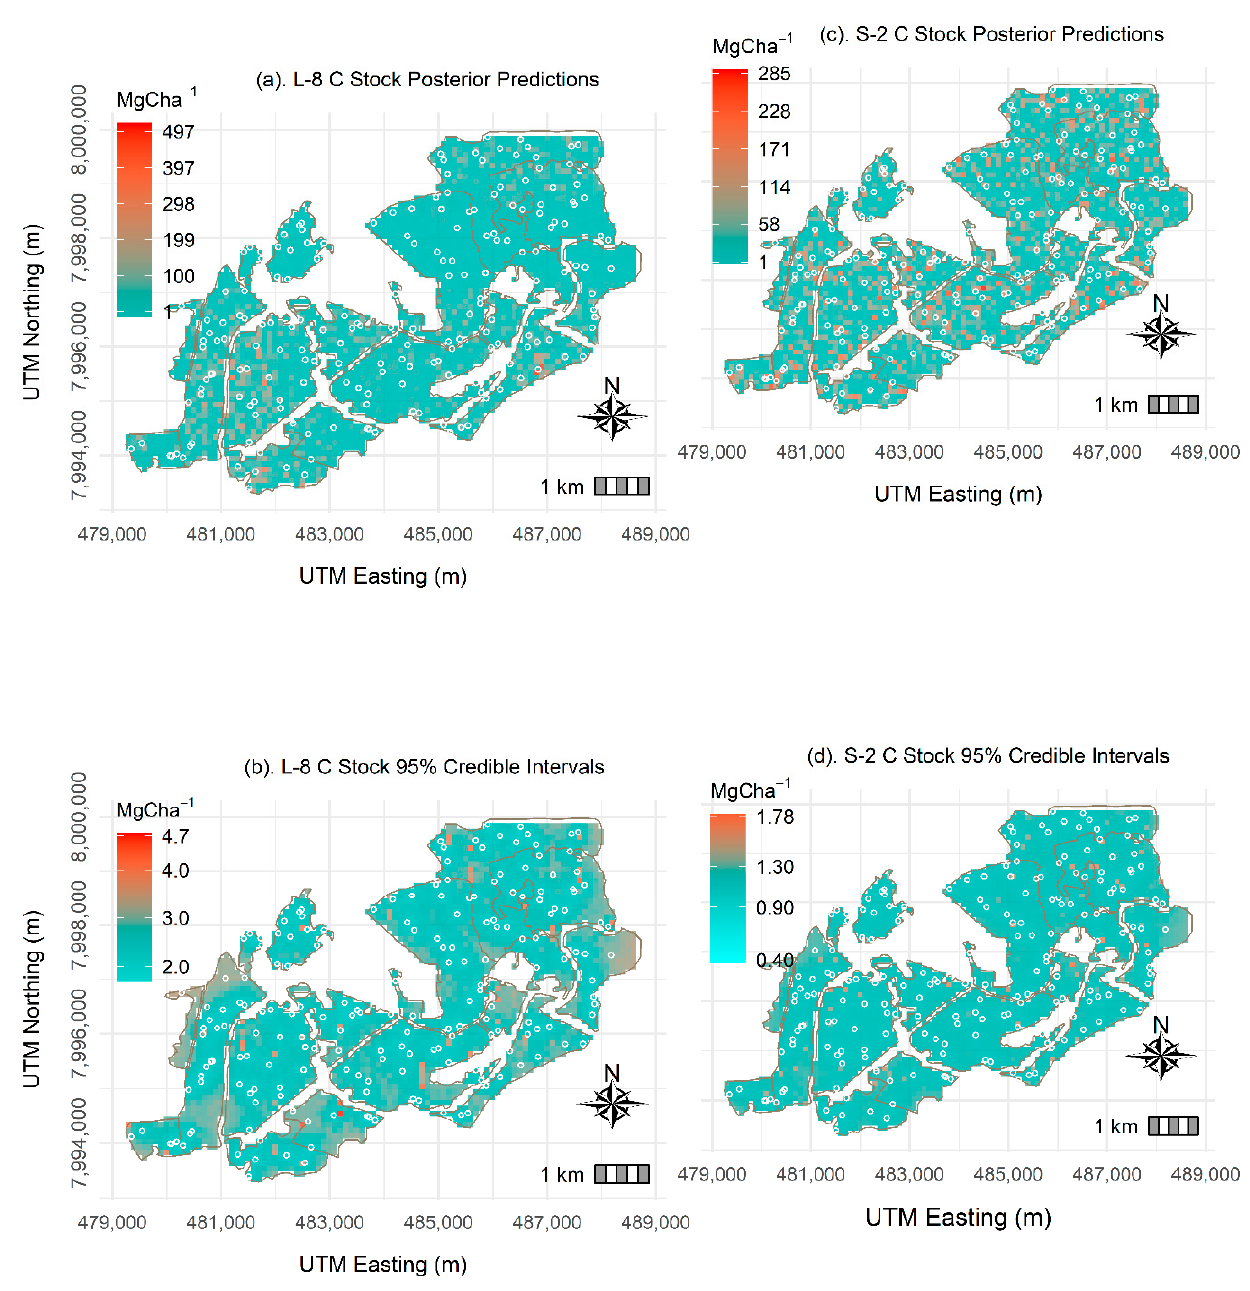
Figure 4. Bayesian Landsat-8 (L-8)- and Sentinel-2 (S-2)-based C stock posterior predictions alongside 95% credible intervals